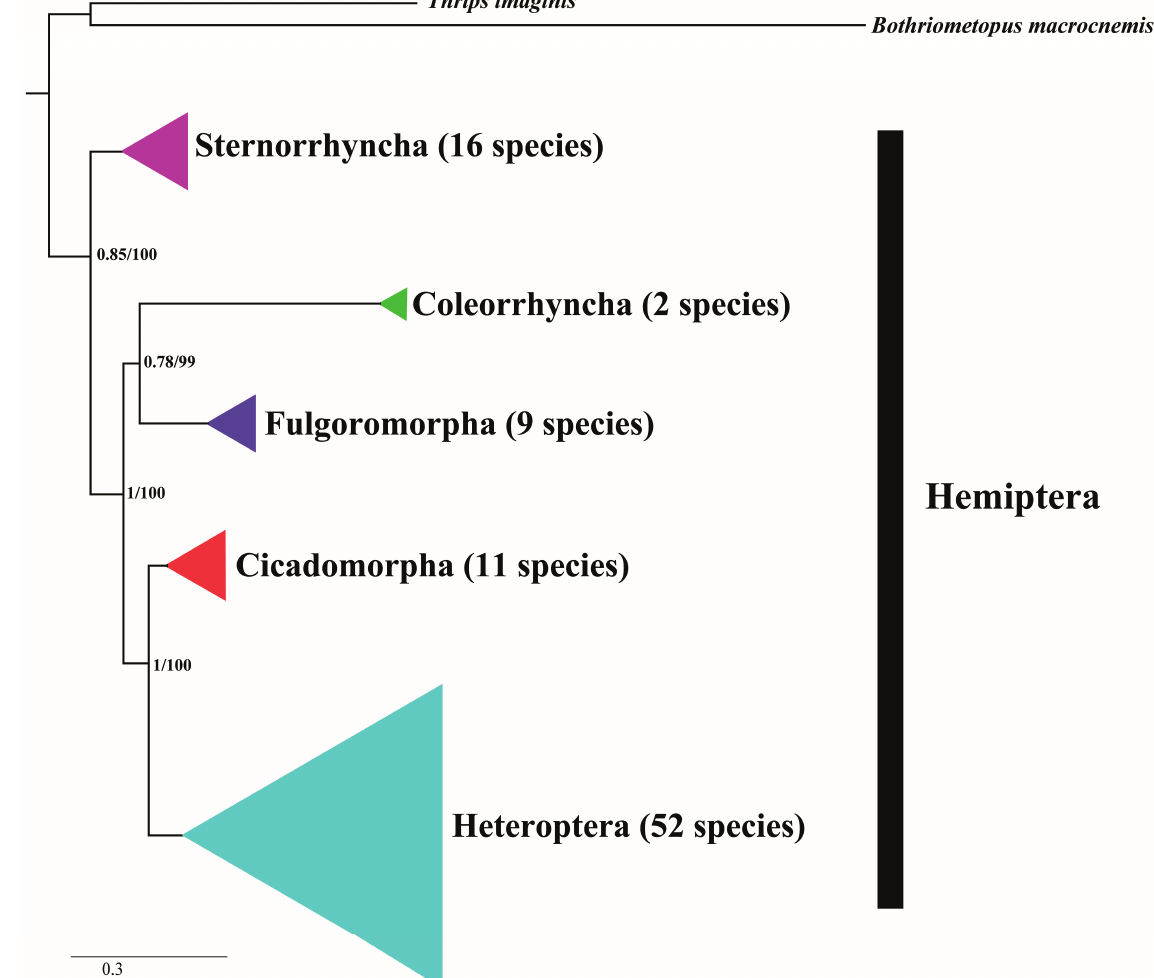
Figure 7. ML and BI Phylogenetic tree inferred from 90 hemipteran mitogenome sequences based on 13 PCGs. The node support values are the Bayesian posterior probabilities (BPP) and the bootstrap (BS)